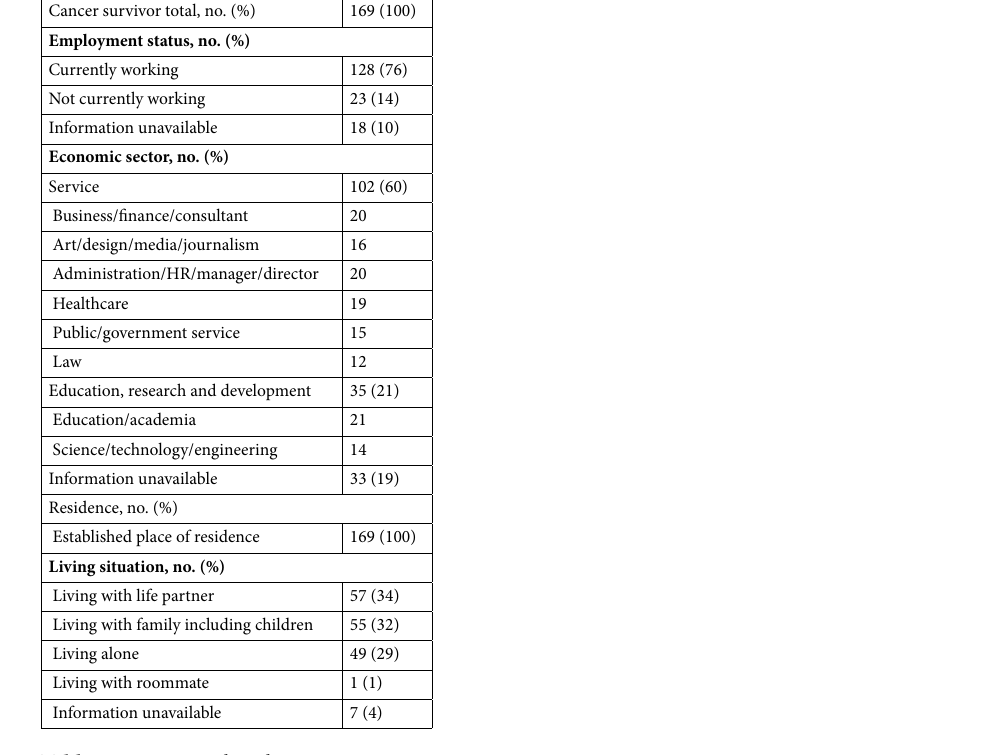
Table 1. Demographic